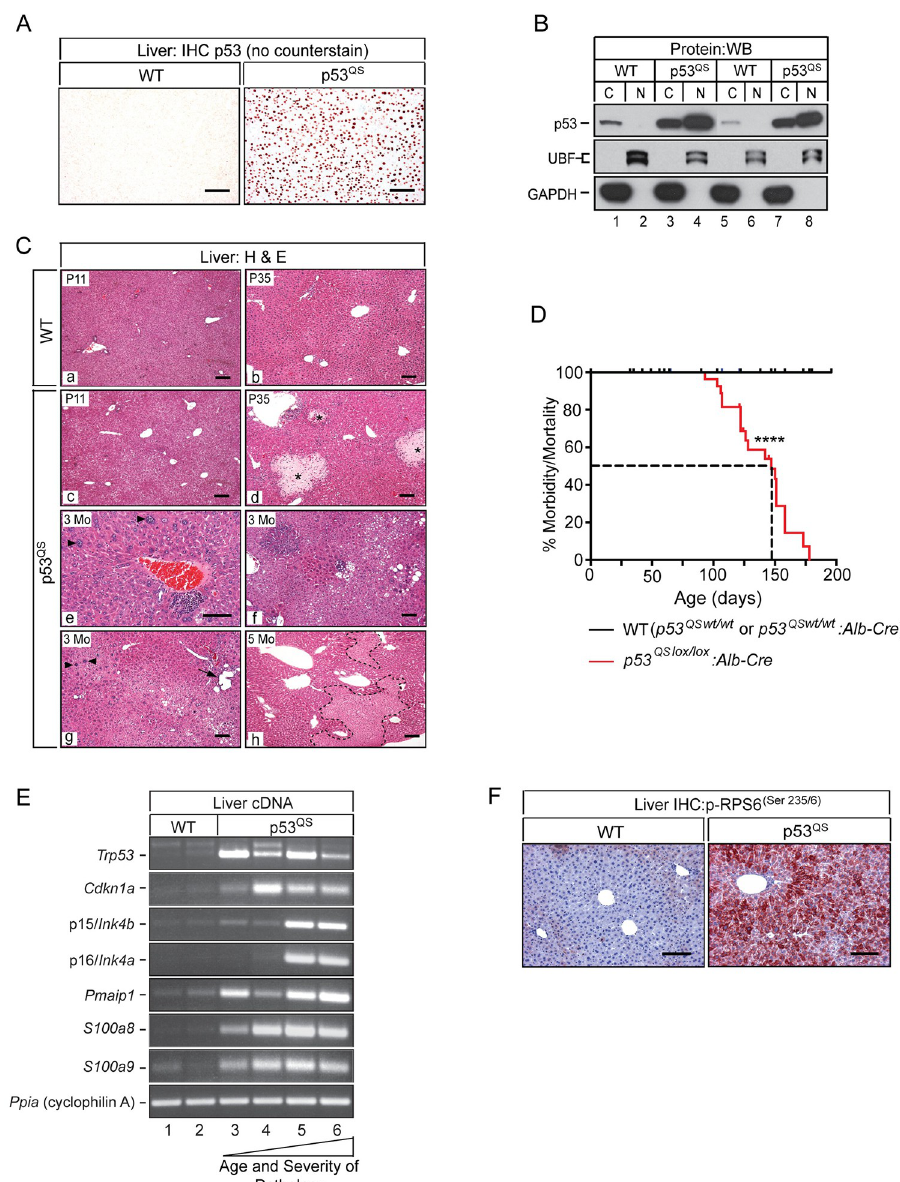
Fig 8. Hepatoblast-specific expression of p53 QS results in chronic liver failure preceded by induction of senescence and innate immunity and activation of mTOR. (A) p53 IHC performed on liver sections from a WT (left) and p53 QS expressing mouse (right) showing robust nuclear expression of the p53 QS mutant in hepatocytes. Original magnifications, x125. (AEC Chromogen (orange/red), no counterstain). (B) Western blot of fractionated cytoplasmic (C) and nuclear (N) proteins isolated from the livers of 2 WT mice (lanes 1, 2, 5 and 6) and 2 p53 QS mice (lanes 3, 4, 7 and 8) with a p53-specific antibody. Immunoblotting of the same lysates using antibodies specific for the nuclear protein UBF (upstream binding factor) and the cytoplasmic protein GADPH confirm enrichment of nuclear and cytoplasmic proteins after fractionation. (C) H&E stained sections of WT (a, b) and p53 QS livers (c-h) showing age-dependent progression of disease in p53 QS livers. Regional hepatocyte vacuolization, evident at P11 (c) is followed by focal hepatocyte necrosis (biliary infarcts, � ) by ~5 weeks of age (d). After ~3 months, hepatocytes show increasing heterogeneity across the lobule (e, f, g). Karyomegaly (enlarged nuclei (arrowheads, e and g)), regional hepatocyte vacuolization and biliary dilatation (g, arrow) are common. By ~5 months of age, p53 QS livers show evidence of widespread parenchymal loss (h, necrotic areas bounded by dashed lines) signifying ongoing liver decompensation in the absence of regeneration. Original magnifications; a, b, c, d, g, h and f, x62.5; e, x125. (D) Kaplan-Meier curve of morbidity and mortality in WT and p53 QSlox/lox : Alb-Cre mice. Median survival of p53 QSlox/lox : Alb-Cre mice; 147 days. ���� P < .0001 (Log Rank (Mantel Cox) test). (E) Ethidium-stained gels of Sq-PCR for p53, p21/Cdkn1a , Noxa